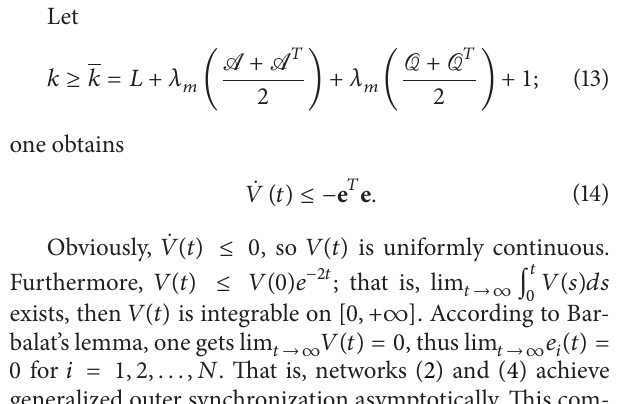
Figure 4: GOS error between the drive and response networks consisting of identical Lorenz systems, with the functional relations being y 𝑖 = (2𝑥 𝑖1 , 𝑥 𝑖1 + 1, 𝑥 2 𝑖3 )